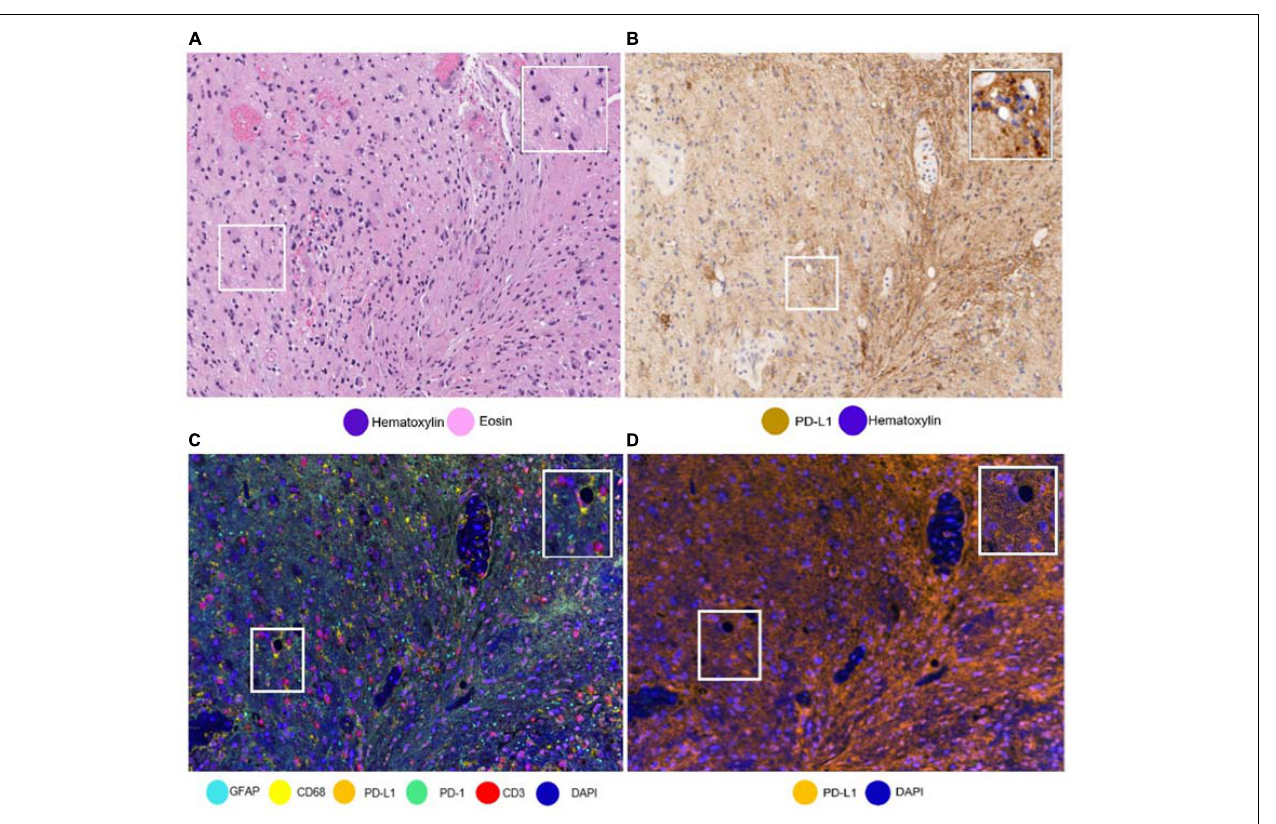
FIGURE 6 | Same areas of a glioblastoma sample with different stainings. The glioblastoma sample stained with (A) hematoxylin and eosin and with (B) PD-L1 immunohistochemistry. It is important to note the challenge to differentiate immune cells from tumoral cells. (C) The glioblastoma sample stained using multiplex immunofluorescence (mIF). Using mIF allows us to differentiate lymphocytes from tumor cells (as seen in 3 CD3 + lymphocytes staining red and glial fibrillar acidic protein staining cyan). (D) mIF with only PD-L1-positive cells. White-framed rectangles in all the images highlight the same area of the sample, which is augmented in the rectangles on the upper right of each